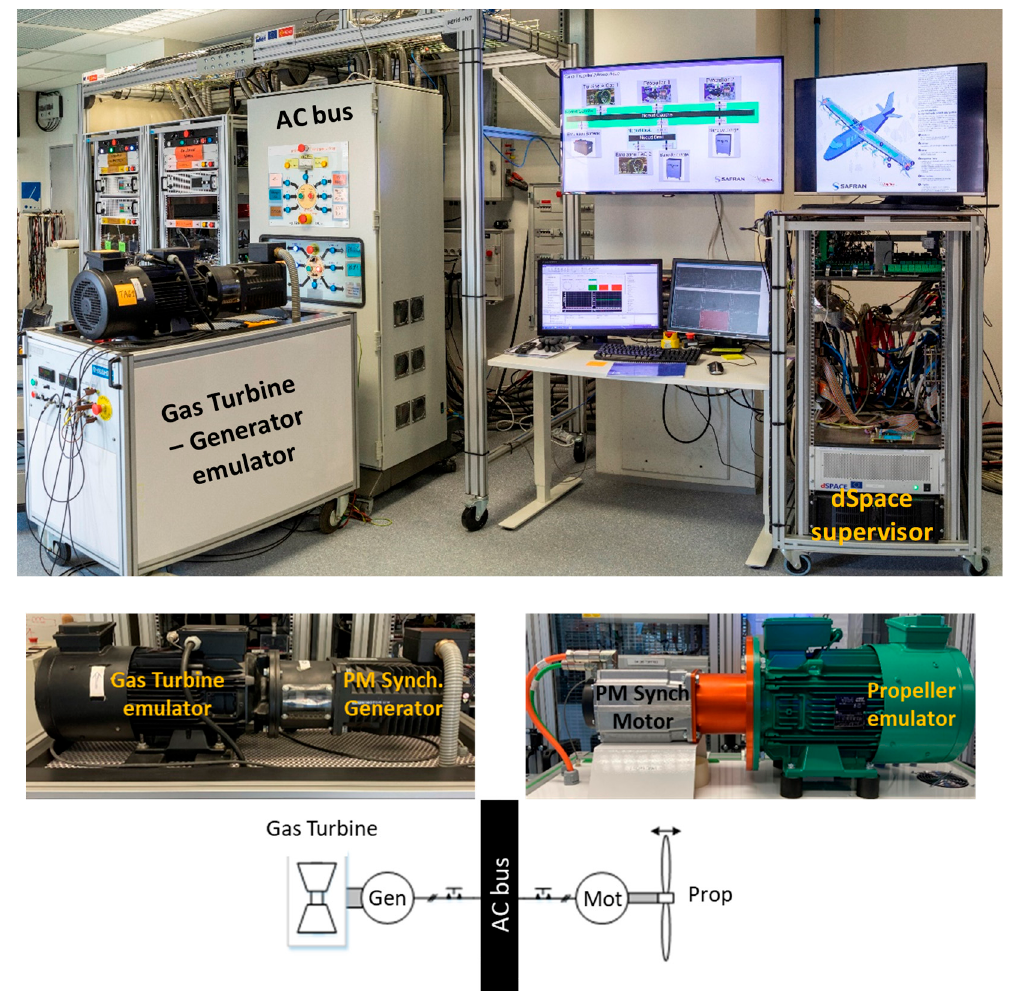
Figure 6. Reduced power scale test bench for AC powertrain functional emulation.